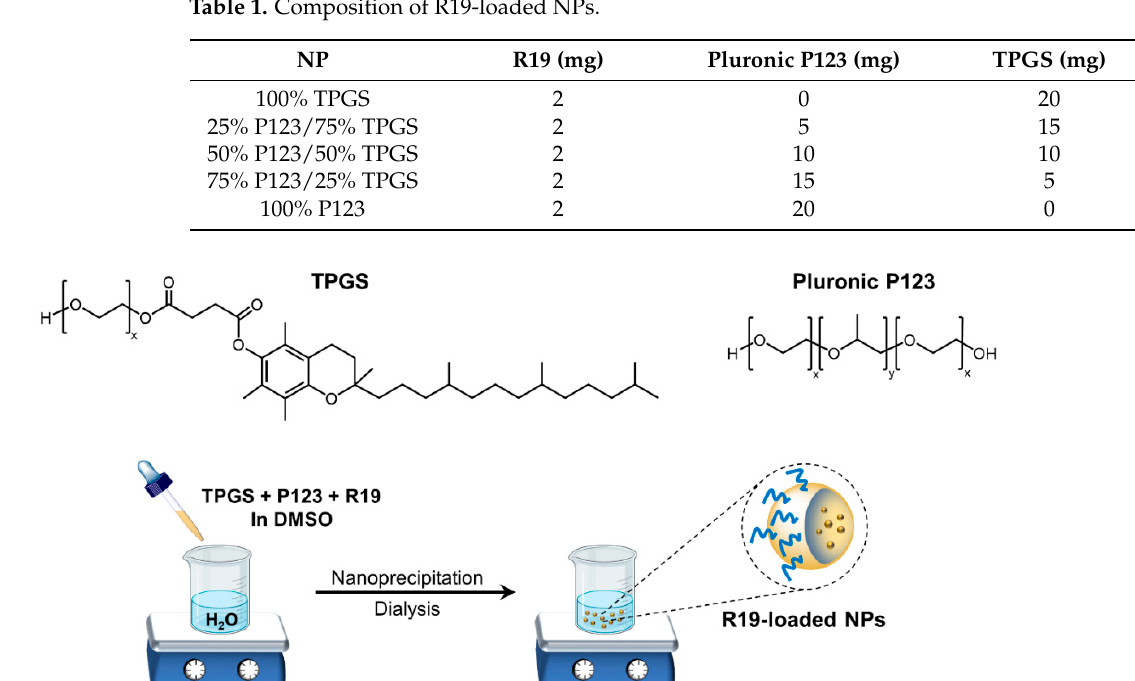
Figure 2. Structures of TPGS and P123 and a schematic of R19 NP preparation by nanoprecipita- tion.